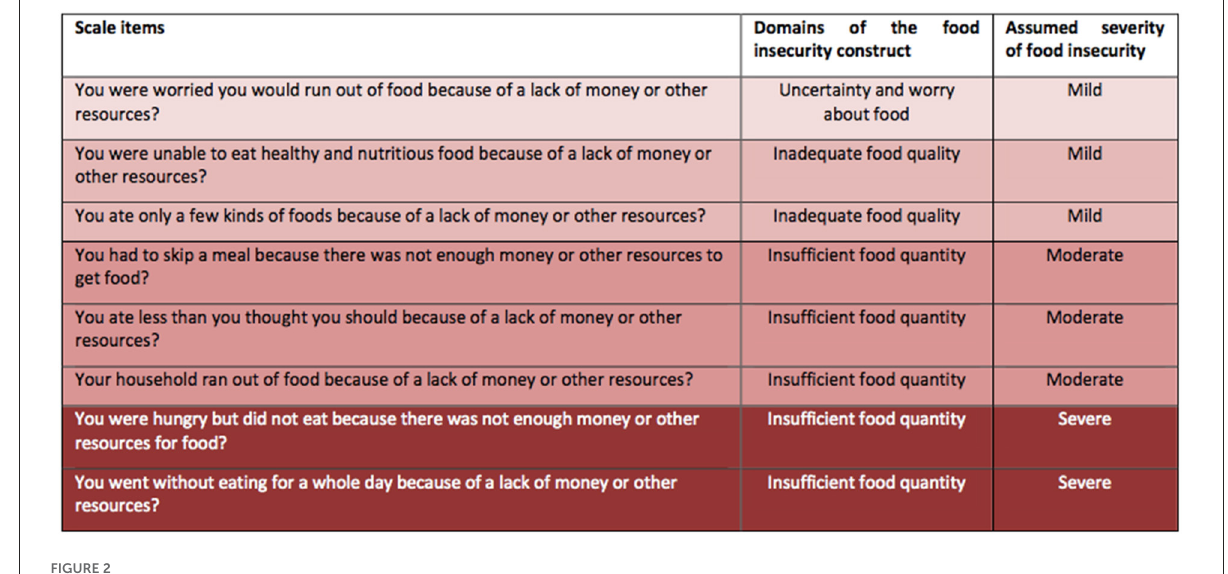
FIGURE2 Food insecurity experience